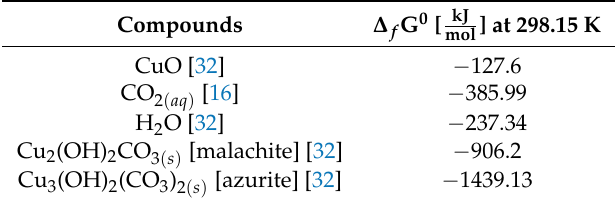
Table A4. Gibbs free energy of formation for educts and products of malachite and azurite formation at 298.15 K and 1